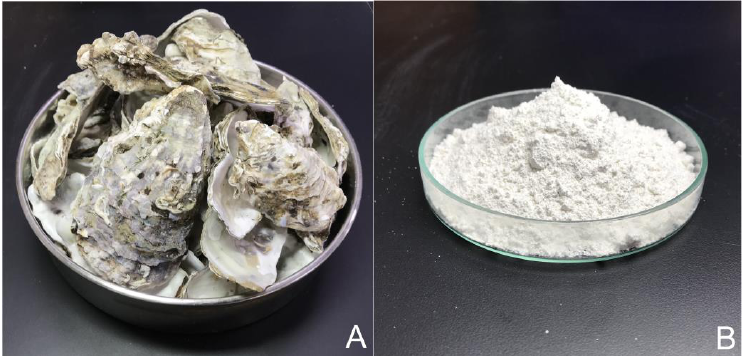
Figure 1. Oyster shell waste ( A ) and its fine powder ( B ).